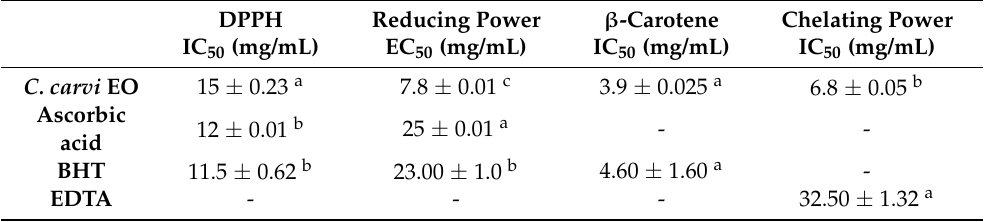
Table 2. Antioxidant activities of caraway essential oil compared to ascorbic acid and BHT. BHT: Butylated hydroxytoluene. The letters (a–c) indicate a significant difference between the different antioxidant methods according to the Duncan test ( p <